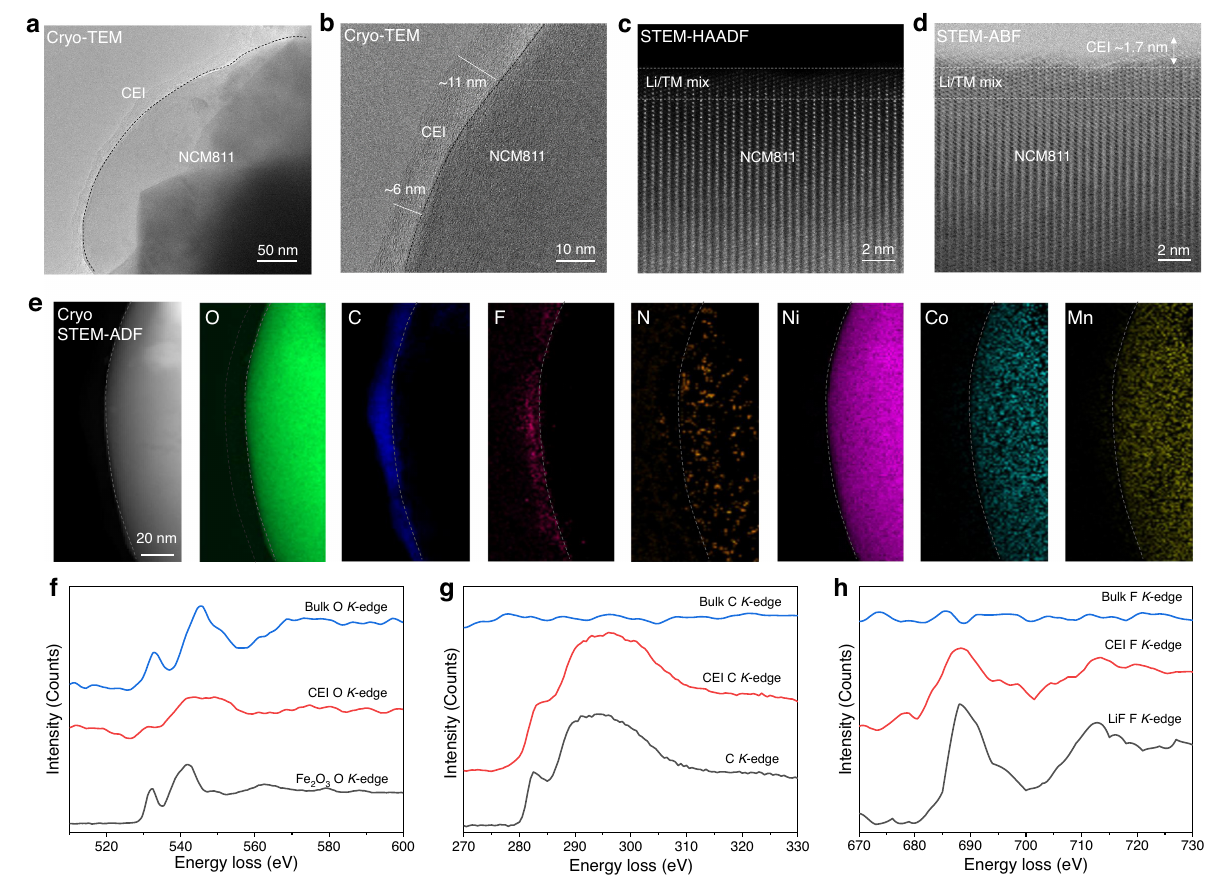
Fig. 4 | Morphology, microstructure and composition of the cathode electro- lyteinterphase(CEI).a , b Cryo-TEMimagesoftheCEIaftercyclinginthe0.6MHE- DME electrolyte. c Atomic-resolution high-angle annular dark fi eld (HAADF) and d annular bright fi eld (ABF)-scanning transmission electron microscopy (STEM) images collected atroom temperature. A Li/TM (TM: transition metal) mixed layer was observed near the surface of the particle with a thickness of around 2nm in both the HAADF and ABF images, in addition, a layer around 1.7nm was found on